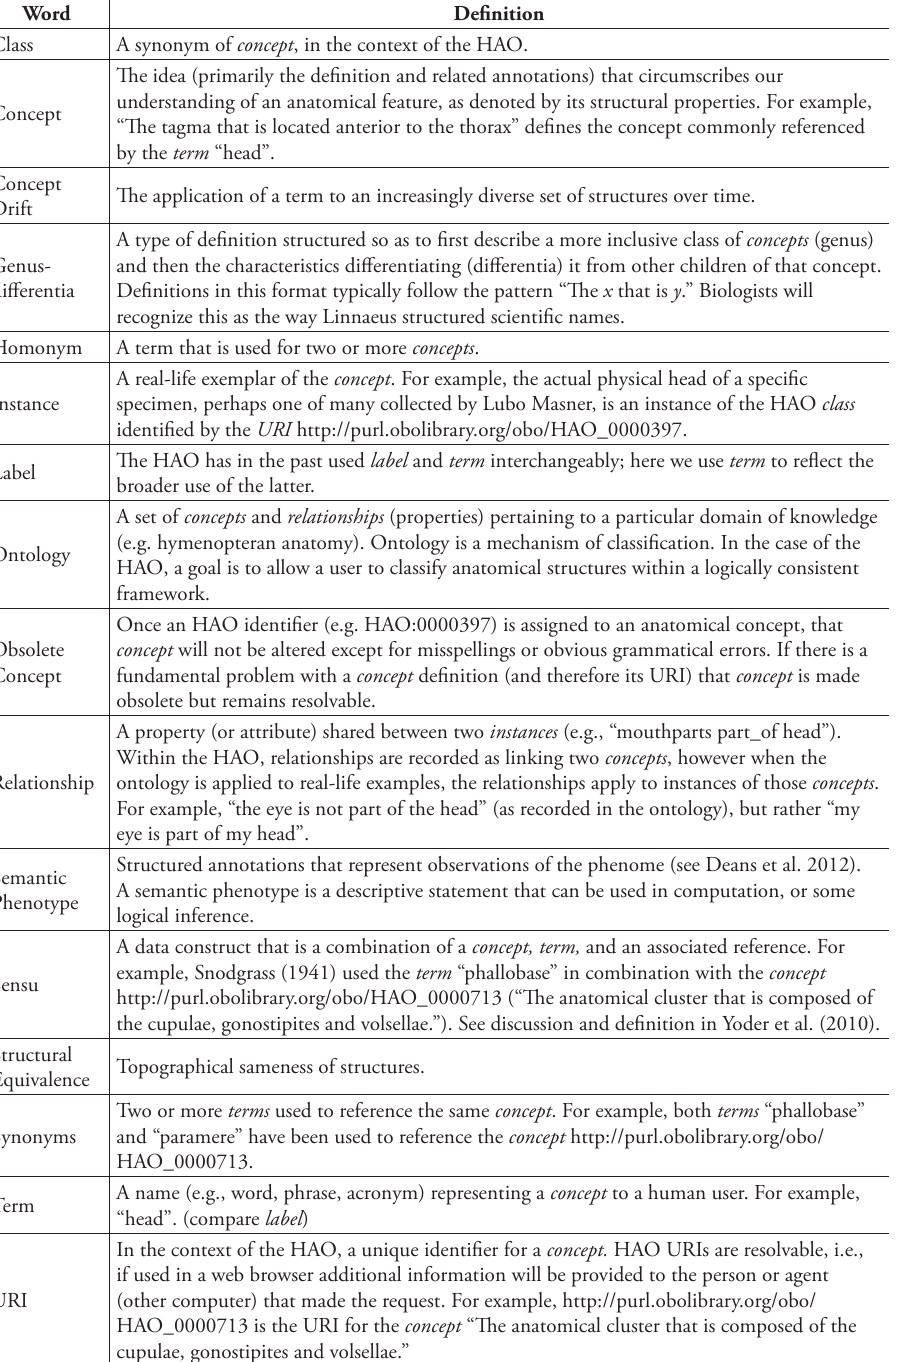
Table 1. Glossary of ontology-related